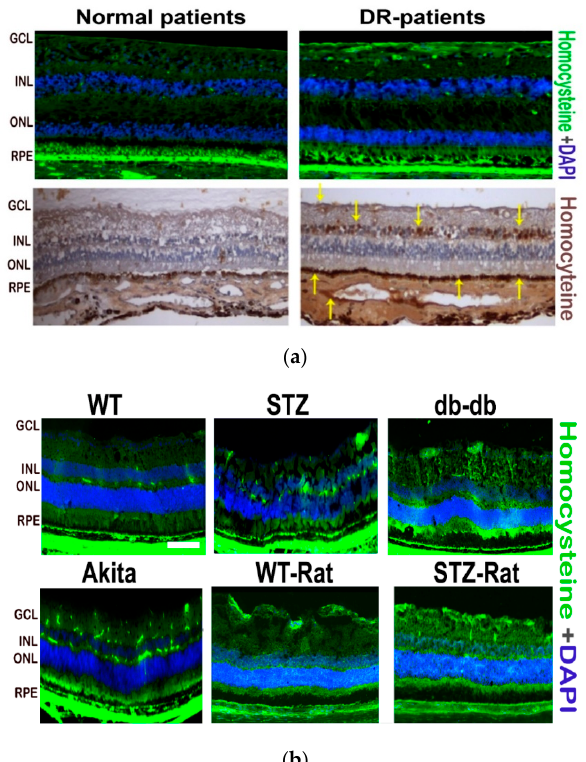
Figure 2. Immunolocalization of Hcy in diabetic retina. ( a )Immunoflourescent staining (top panel) of retinal cryosections from diabetic patients (green fluorescence detects Hcy and 4’6-diamidino-2- phenylindole (DAPI) (blue) detects nuclei). Immunohistochemical detection (bottom panel) of Hcy (brown) in retinal cryosections from diabetic patients (yellow arrows). ( b ) Immunoflourescent staining of retinal cryosections from wild-type (WT) mice (upper left panel), STZ-injected mice (upper middle panel), db/db mice (upper right panel), Akita mice (lower left panel), WT rats (lower middle panel) and STZ-injected rats (lower right panel). Green fluorescence detects Hcy and DAPI (blue) detects nuclei.